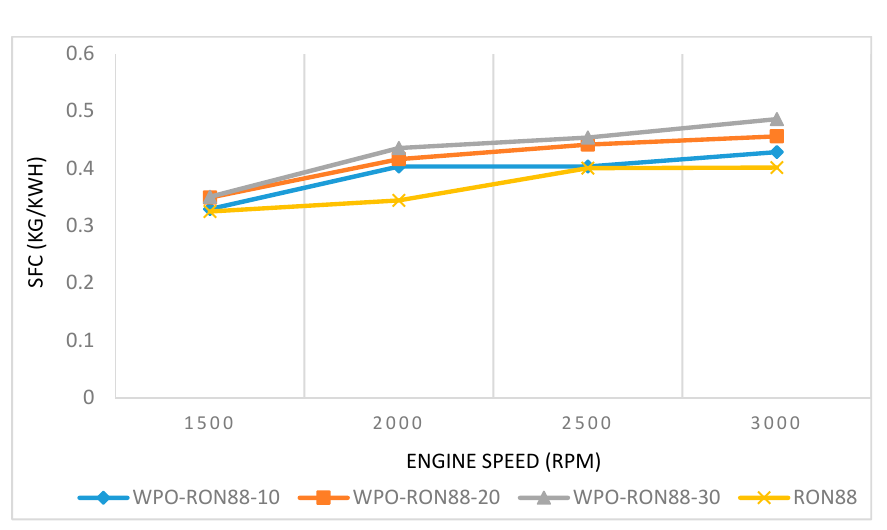
Figure 7. Effect of WPO-RON88 blend on thermal efficiency (%), compared to RON88.